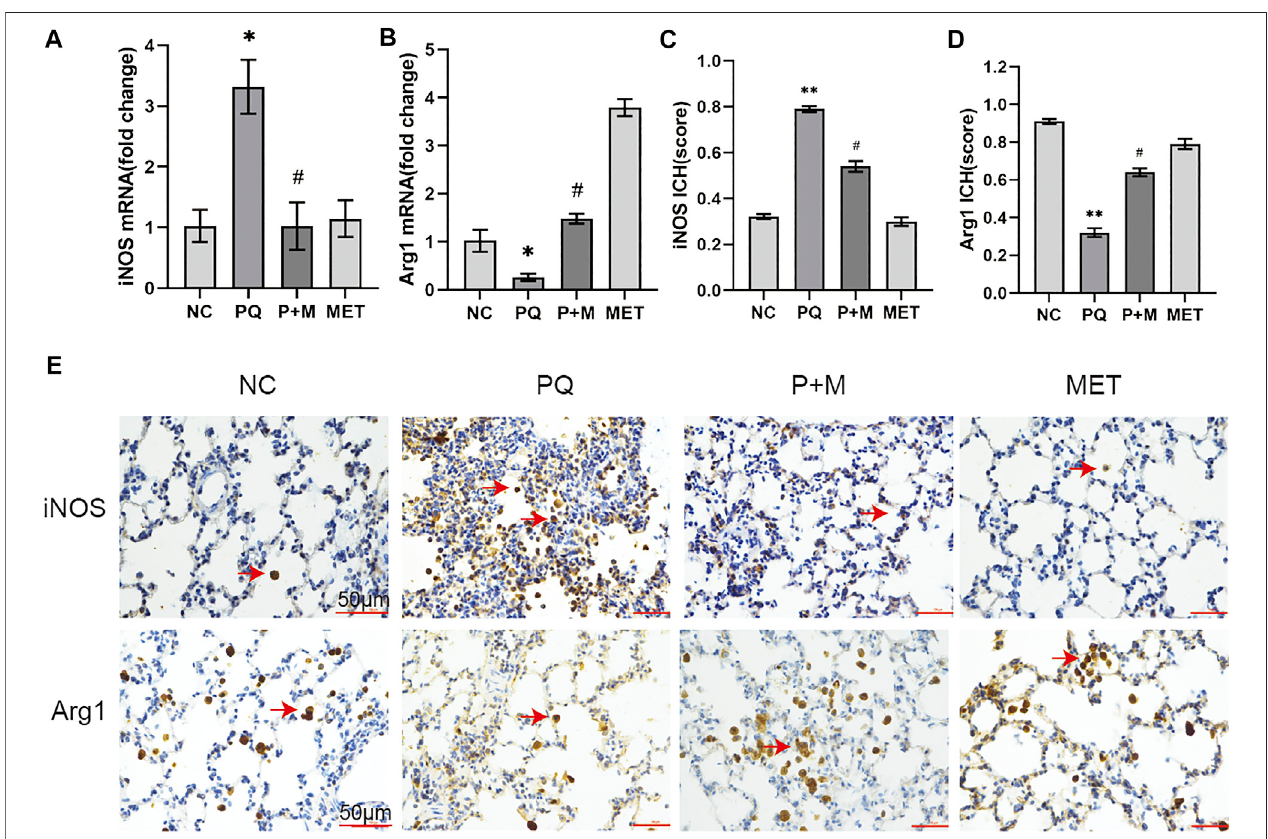
FIGURE 3 | The effect of MET on the expression of iNOS and Arg1 in the lungs of PQ-poisoned rats. mRNA expression level of iNOS (A) and Arg1 (B) ( n = 3), the semi quantitative analysis of immunohistochemical of iNOS (C) and Arg1 (D) ( n = 3), (E) immunohistochemical of iNOS and Arg1 in lung tissue. Compared with the NC group, * p < 0.05, ** p < 0.01; compared with the PQ group, # p < 0.05.